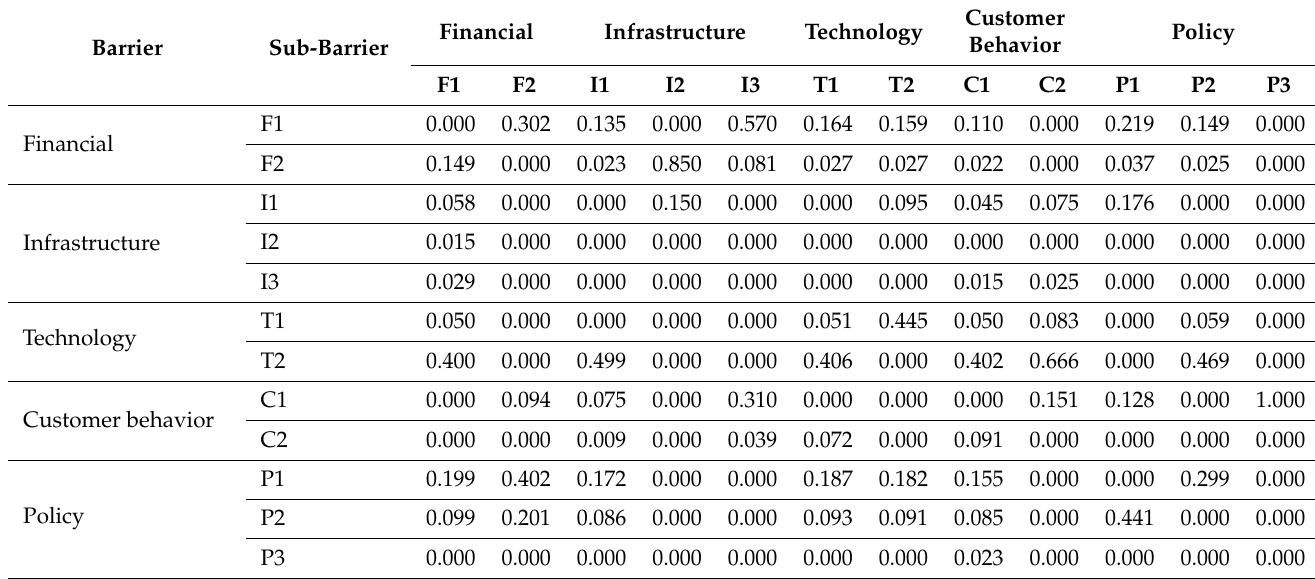
Table A1. Weighted